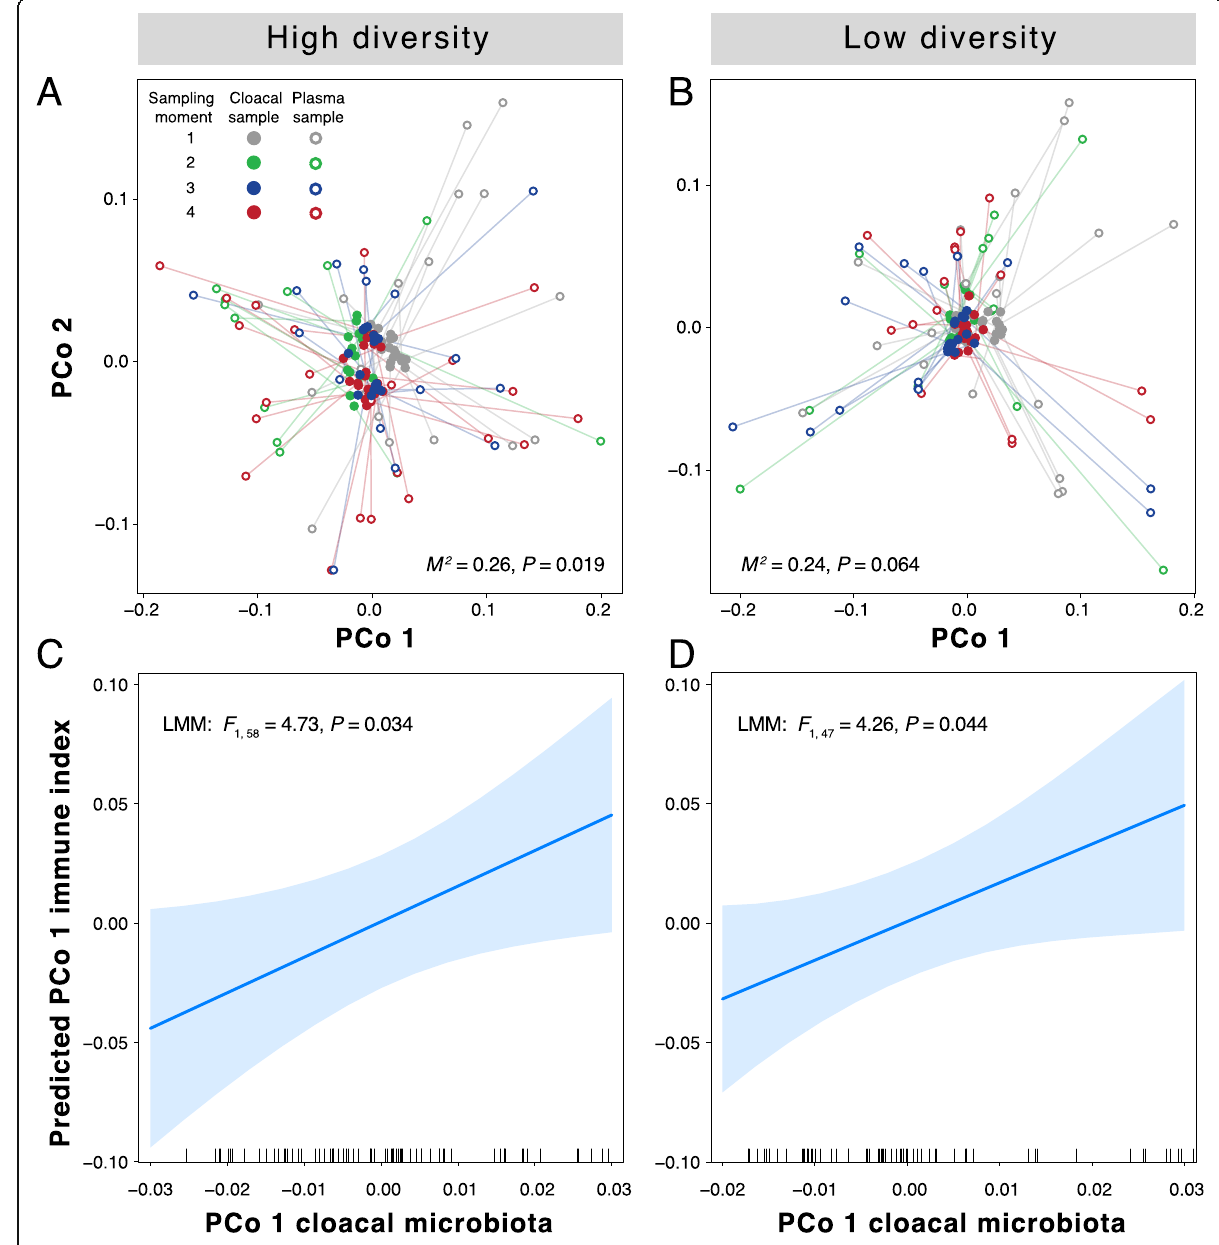
Fig. 4 Procrustes analysis of immune function and cloacal microbiota states. a , b Procrustean superimposition of two multivariate data sets for birds exposed to ( a ) high diversity and ( b ) low diversity soils: multivariate immune index based on four immune indices (agglutination titer, IgY concentration, lysis titer, haptoglobin concentration) (open symbol) and taxon occurrence in cloacal microbiota based on unweighted UniFrac (closed symbol). Procrustes analysis scaled and rotated both ordinations to the best Procrustean fit ( M 2 ) and protest statistics are shown in each plot. c , d PCoA scores of immune function of birds exposed to ( c ) high diversity and ( d ) low diversity soils predicted by PCoA scores for phylogenetic taxon occurrence of cloacal microbiota. The line depicts the predicted relationship and the shaded area depicts the 95% CI of the predictions. c , d Linear mixed-model inferences are controlled using subject identity and replicate room as random